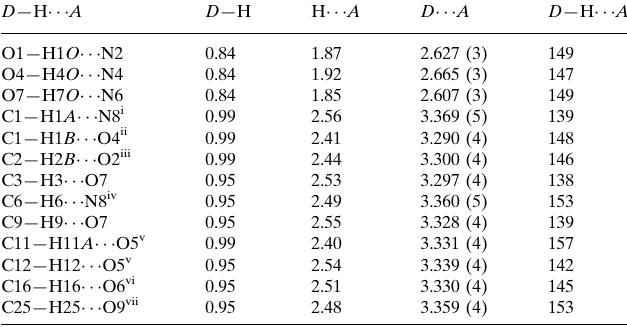
Hydrogen-bond geometry (A˚ , (cid:3)